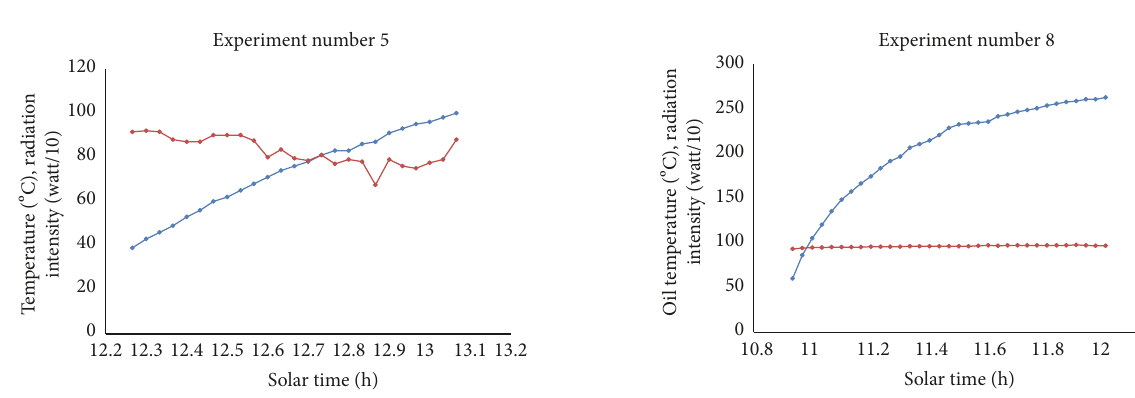
Figure 12: Plot of temperature (blue) and solar radiation intensity (red) versus time for the second experiment with 4 kg of water load. Radiation intensity is divided by 10 to fi t the scale.